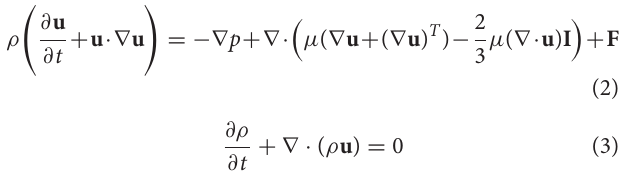
FIGURE 2 | Sketch of the rotationally symmetric geometry with a section containing a homogeneously distributed indicator (green area) and a blood analog (yellow area). After applying a laminar flow, concentration curves are obtained as the mean concentration at the pipe’s cross-sectional area at the three marked locations (blue, red, and orange). The corresponding dilution curves are shown in Figure 3 . Please note that the scale of the figure does not represent the scale used in the in silico